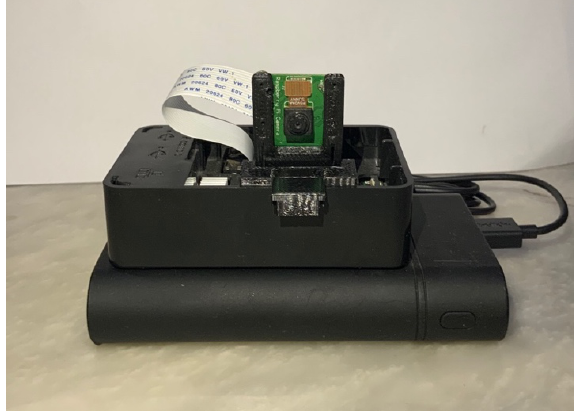
Figure 2. Sensor node of the proposed IoVT